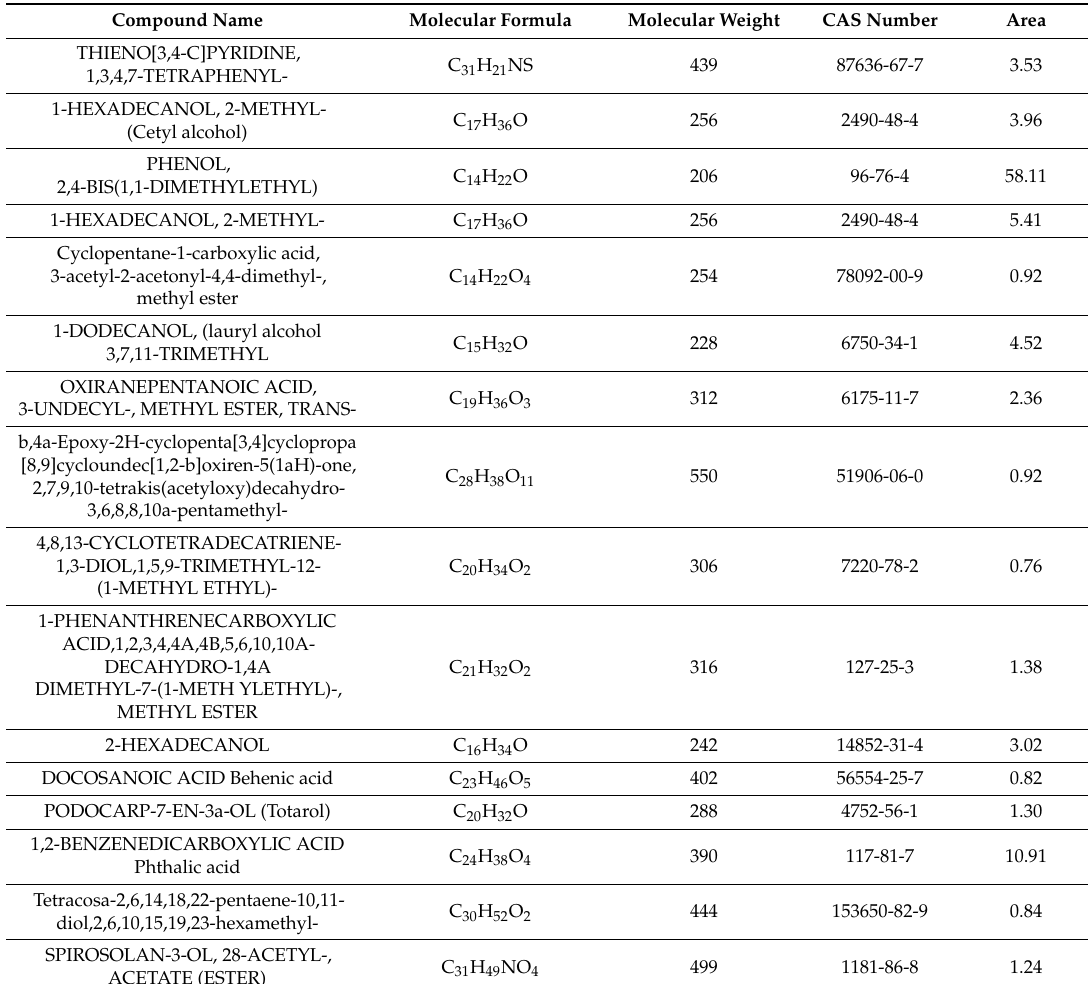
Table 1. Gas chromatography (GC) analysis of ethyl acetate extract of spent mushroom substrate extracts